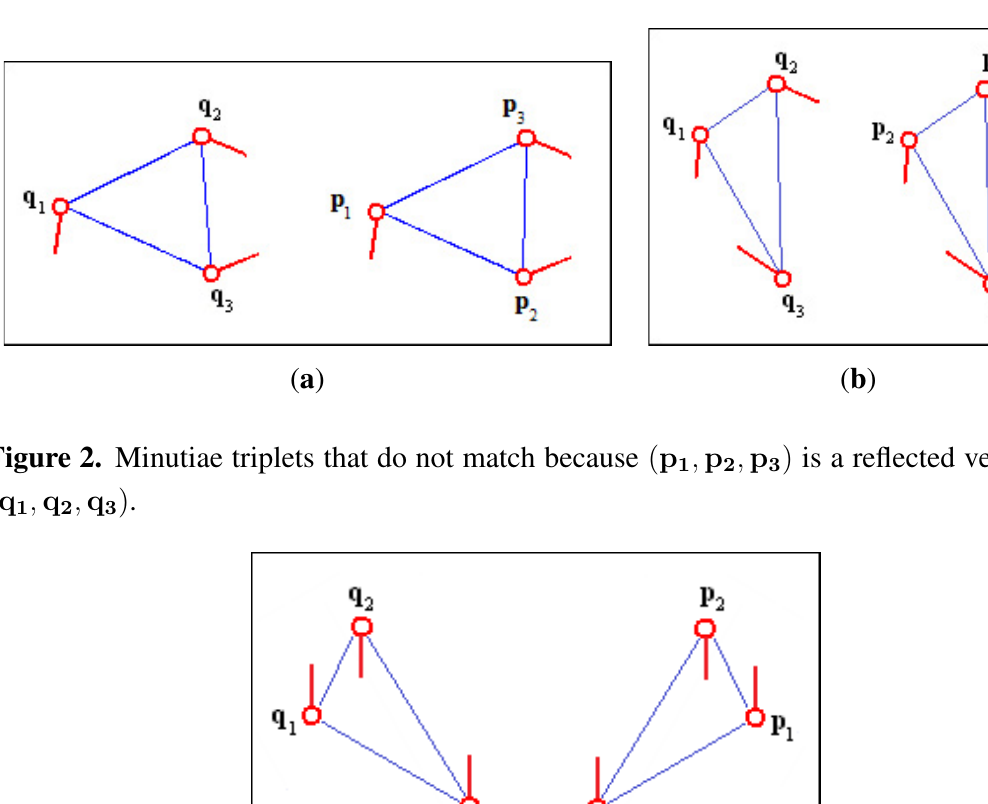
(left triplet) with the 1